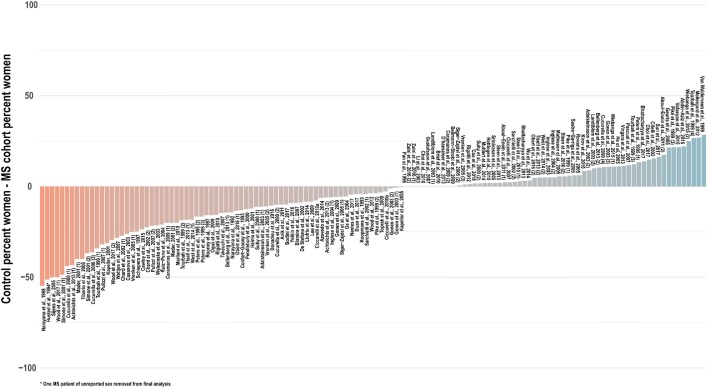
Cross-sectional analyses of relapsing, progressive, unspecified, and mixed subtypes of multiple sclerosis published between 1992 and 2018 have tended to feature control groups with a lower proportion of women than the patient groups with whom they are compared. An investigation of 134 cross-sectional analyses published between 1992 and 2018 that reported group sex ratios found that, on average, control groups contained 6 percentage points fewer women (range 55% fewer to 30% more) than experimentally compared groups of multiple sclerosis patients, with significant disparities from experimental groups in control for both proportion (t = −2.9, two-tailed p = 0.004) and absolute number (t = −2.6, p = 0.01) of tested women. Distinct analyses from the same publications denoted in parentheses. MS: multiple sclerosis.